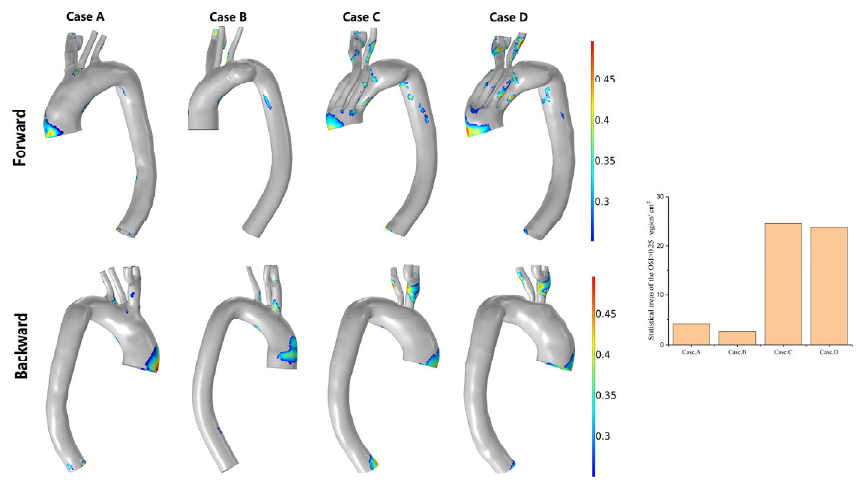
Figure 9. Changes in the regional distribution of the OSI of >0.25 and the area statistics of the four models. (Case A ) Normal model; (Case B ) Preoperative model; (Case C ) 1-week postoperative model; (Case D ) 6-week postoperative model.